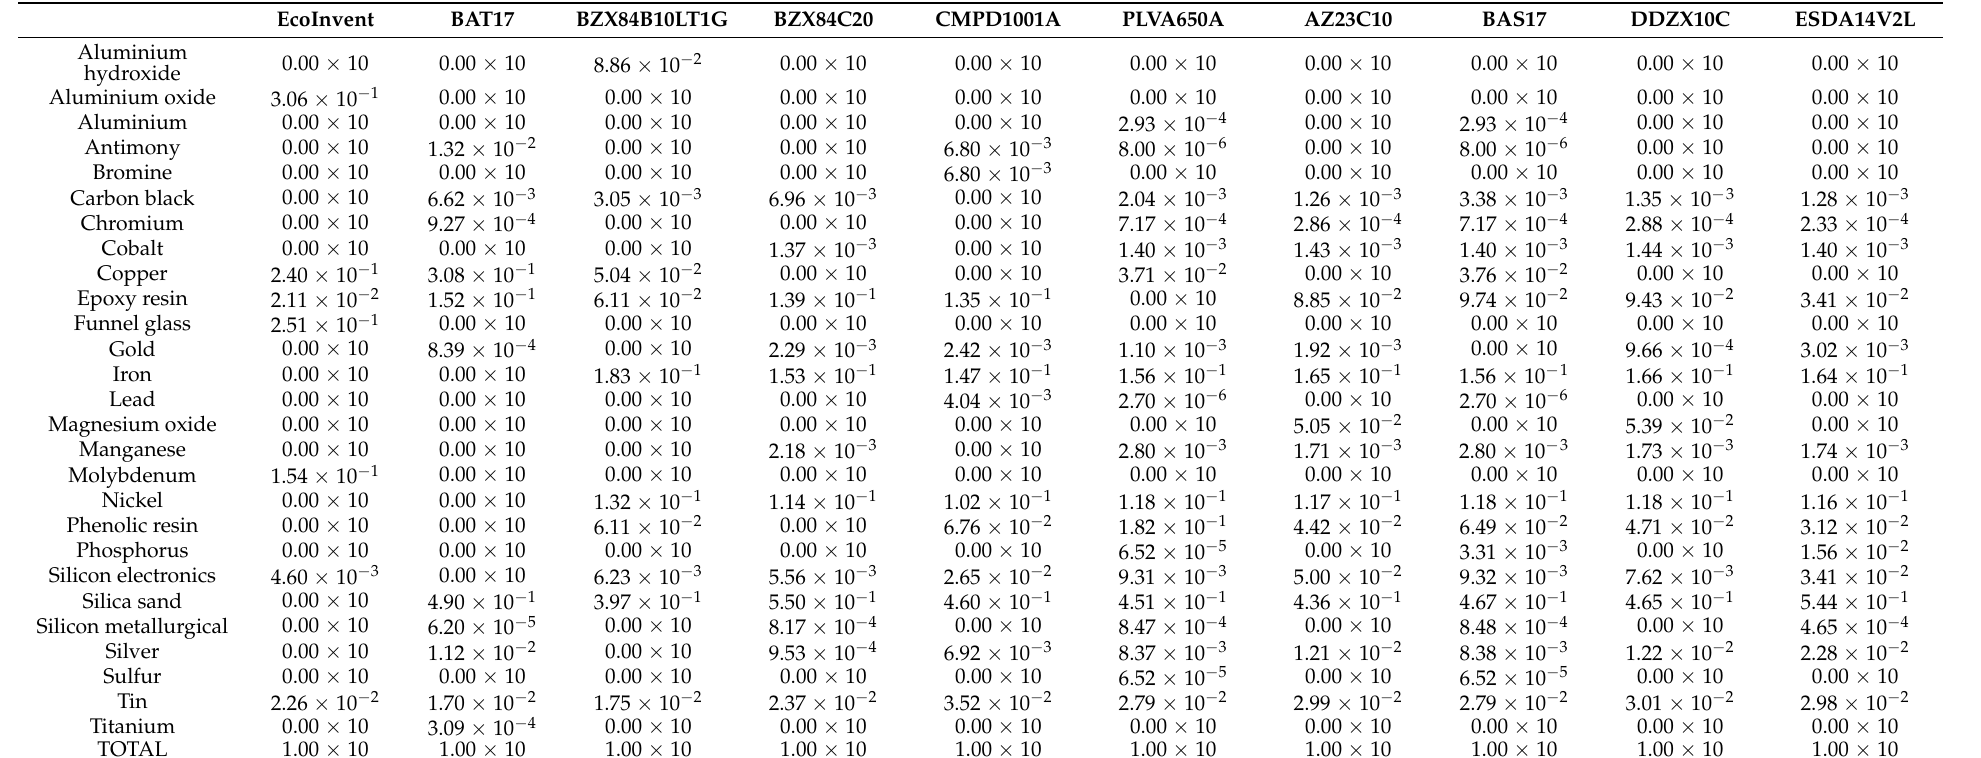
Table 1. Material composition for 1 g of studied SMD